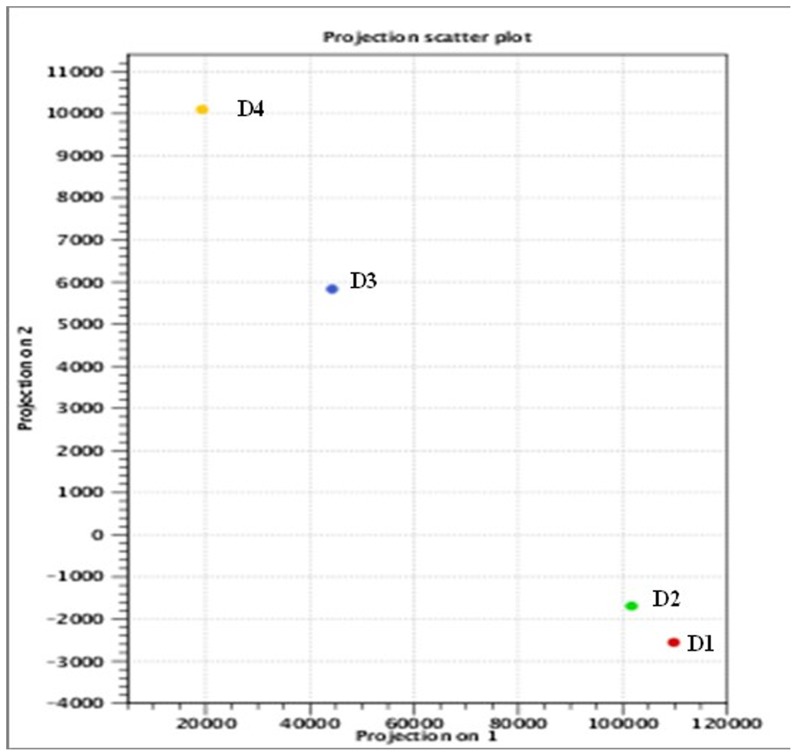
Principal component analysis of the leaf transcriptome of Citrullus colocynthis at 0 (D1), 24 (D2), 36 (D3) and 48 (D4) hours of withholding water.PCA analysis was conducted using the CLC workbench. The X-axis indicates principal component 1, the Y-axis principal component 2. Data from D1 and D2 are more closely related than data from D3 and D4.